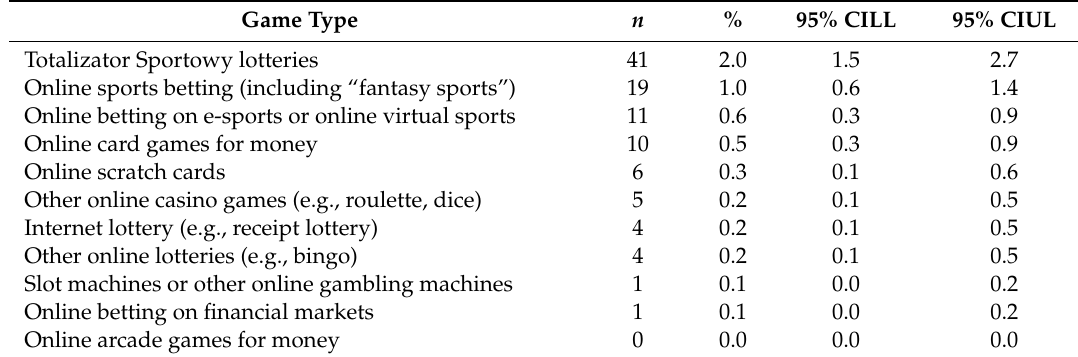
Table 2. Prevalence of forms of online gambling ( N =